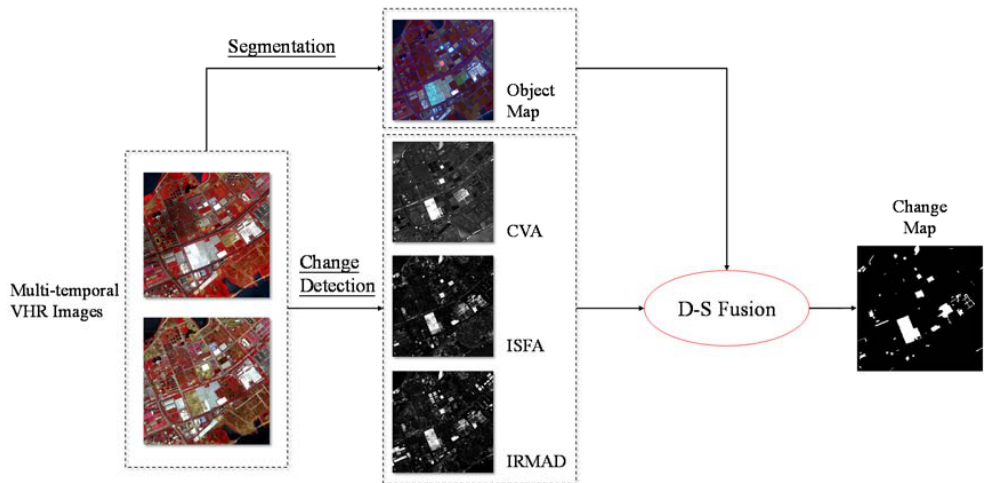
Figure 1. Flowchart of the proposed method.